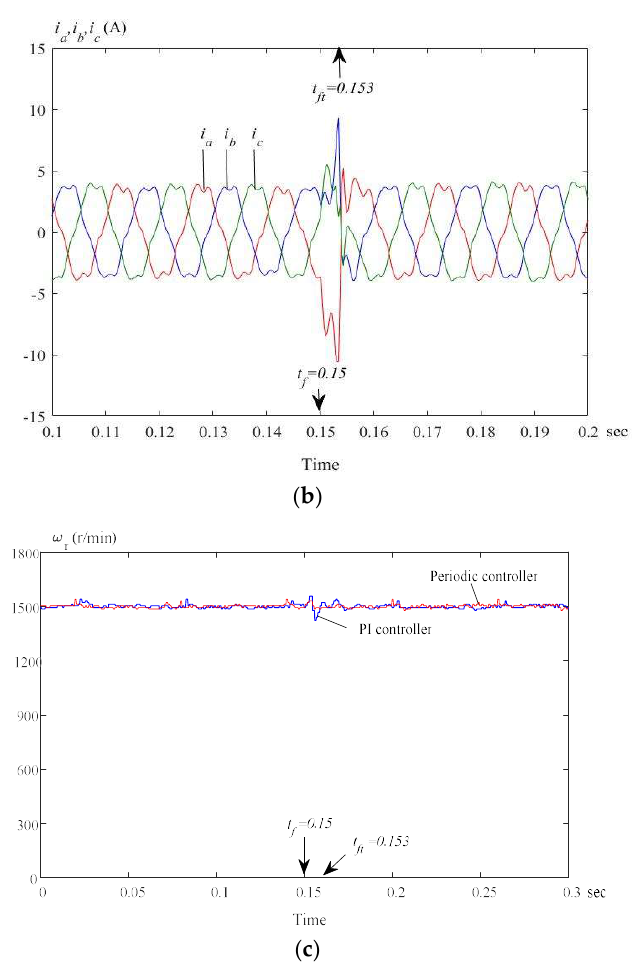
Figure 21. Measured results at 1500 r / min of the fault-tolerant control when the a -phase was short-circuited: ( a ) currents of the PI controller; ( b ) currents of the periodic controller; ( c ) speed responses.